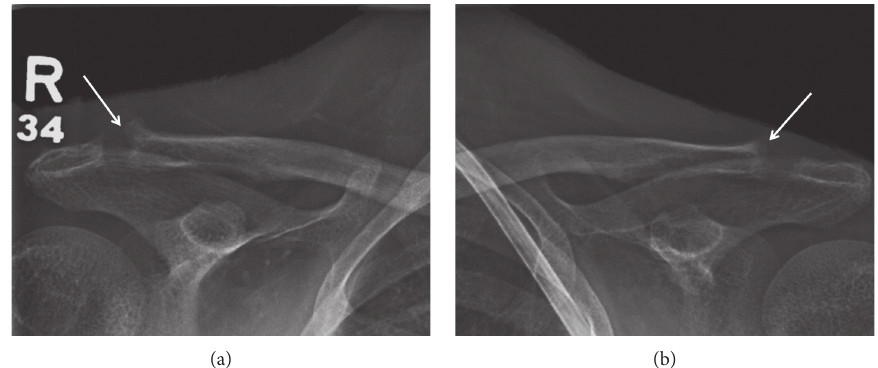
Figure 2: Clavicular subchondral resorption (arrows), widening of the articular space and irregular-feathery articular surface bilaterally.